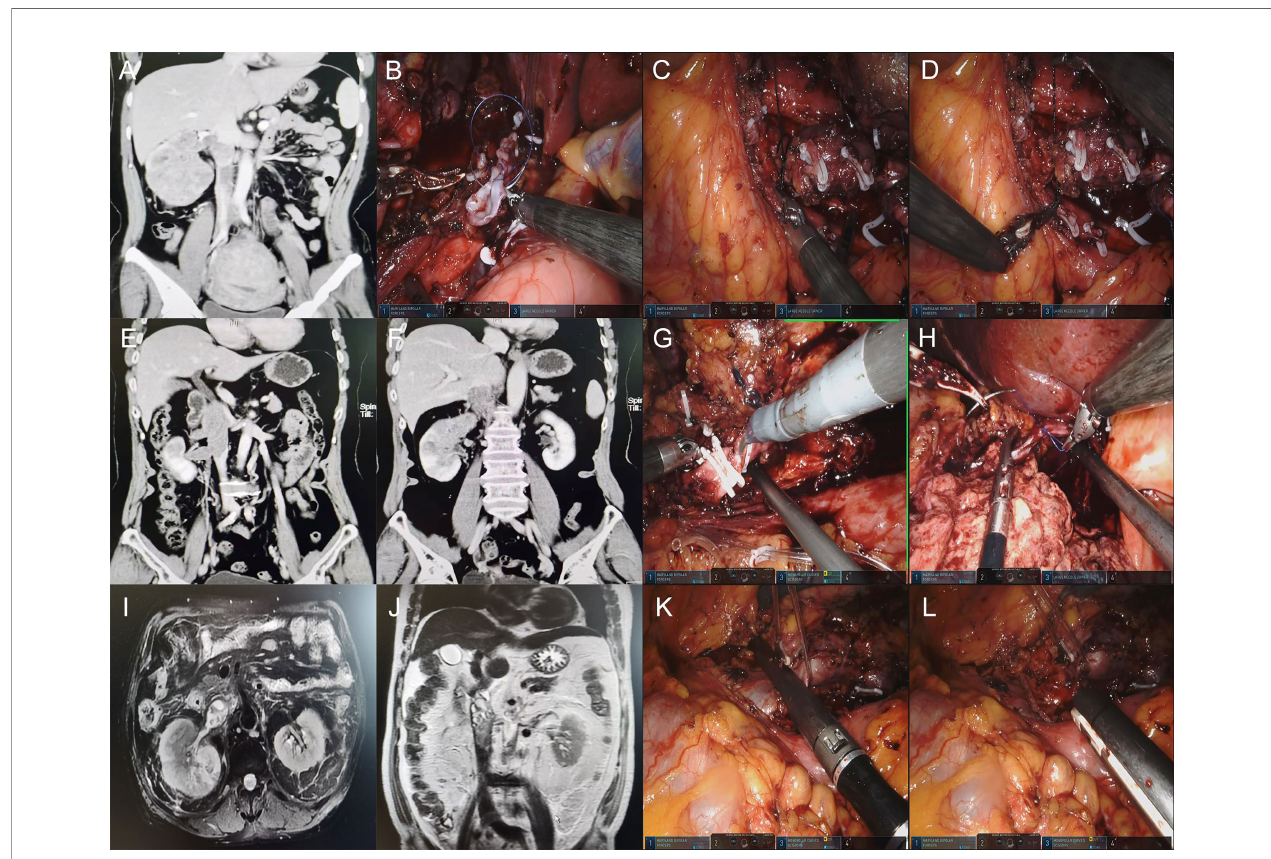
FIGURE 1 | (A, E, F, I, J) Preoperative CTU images of retroperitoneal tumors with IVC tumor thrombus. (B) Suture the proximal IVC with a 4-0 Prolene vascular line. (C, D) Ligation of the distal end of IVC due to the thrombus below the tumor thrombus. (G) Ligation of the distal end of IVC by using double Hem-o-lock. (H) Proximal IVC ligation using a single Hem-o-lock and suture. (K, L) IVC Ligation by using